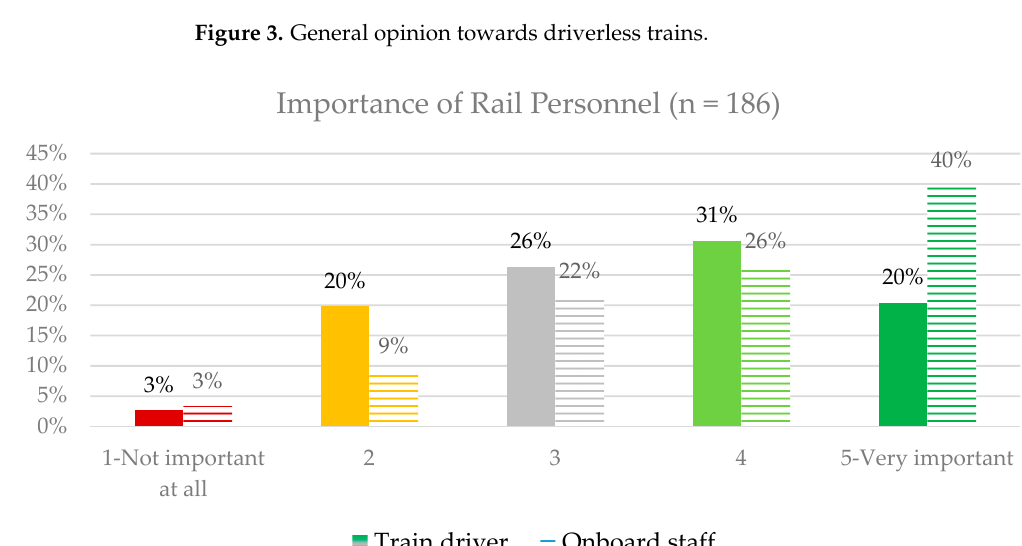
Figure 4. Importance of rail personnel for rail operations.